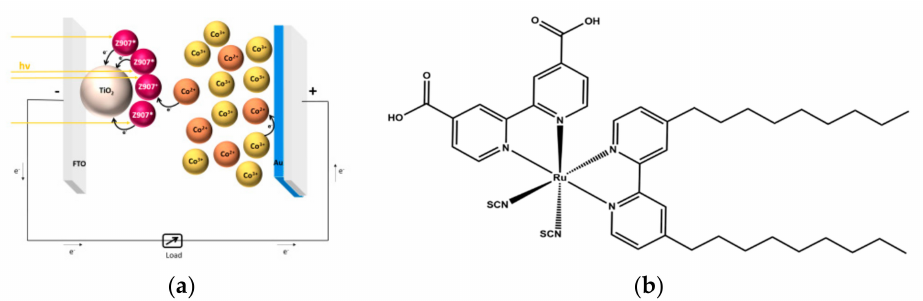
Figure 1. ( a ) Cross-section schematic view of the investigated DSSC. ( b ) Molecular structure of the dye sensitizer Z907 utilized in this